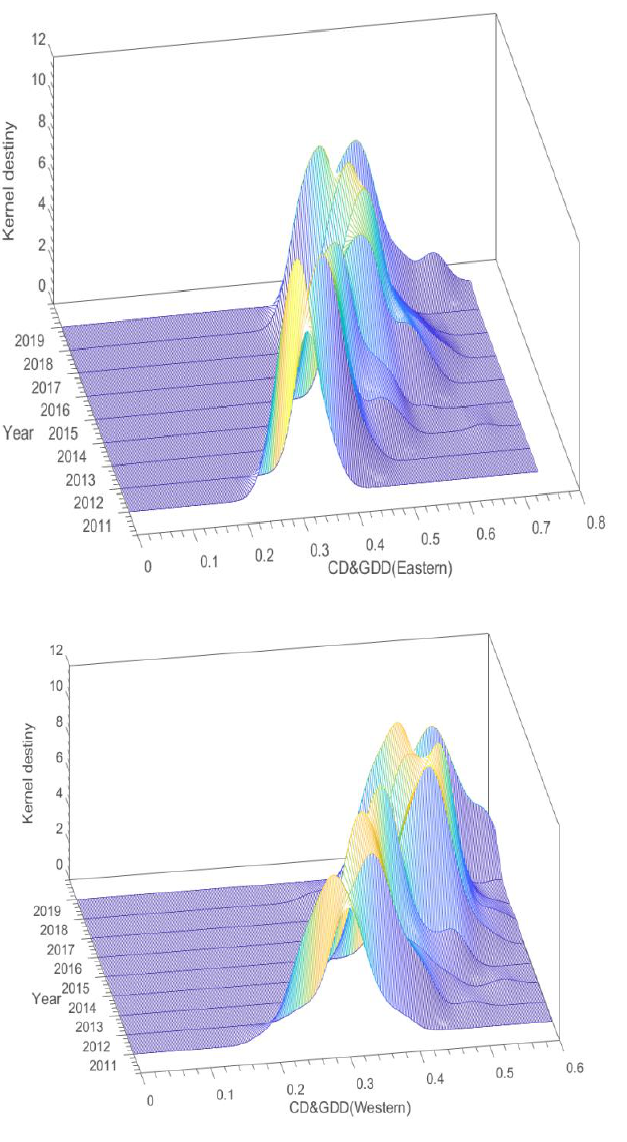
Figure 8. Three-dimensional kernel density maps of CD&GDD in four economic